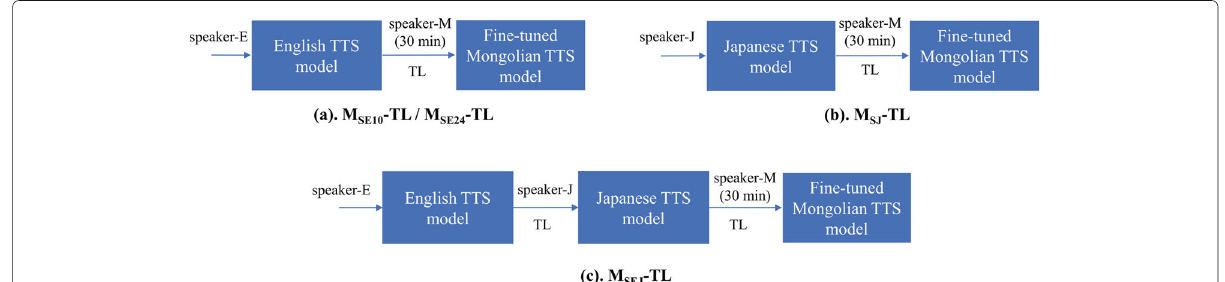
Fig. 3 Training flow diagrams for our single-speaker TTS models. Transfer learning from the source languages to the target language is used, where a are models using only different amounts of the English dataset, b is a model using only the Japanese dataset, and c is a model using the entire datasets of both high-resource languages